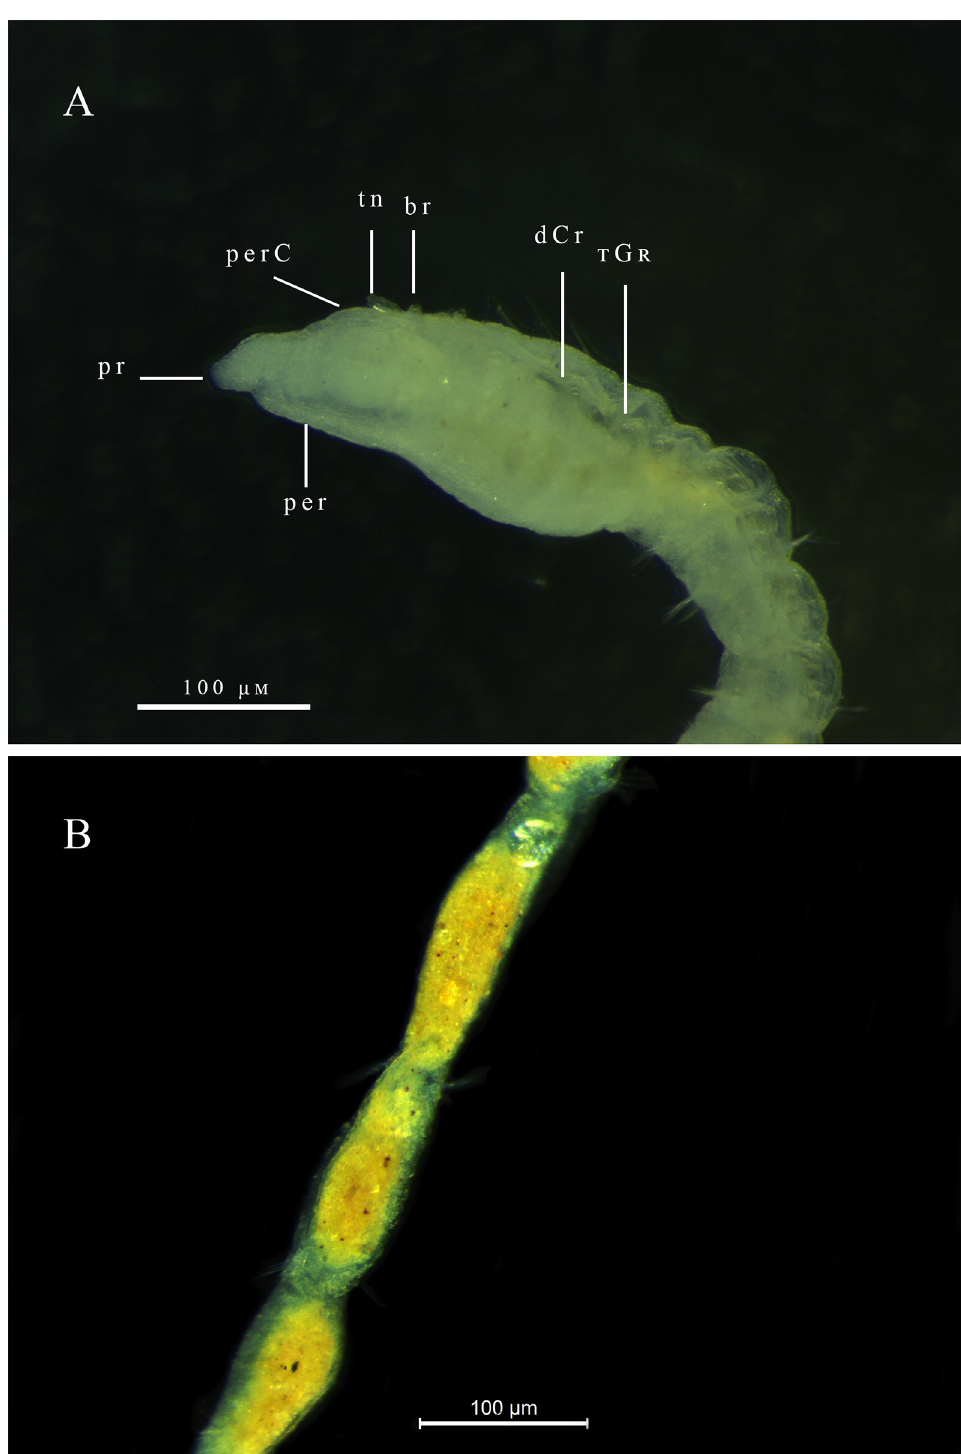
Fig 11. Kirkegaardia papaveroi sp. nov. (A) Anterior end, lateral view; (B) abdominal segments, dorsal view. A and B (MNRJP-003008). Type locality. Atlantic Ocean: Campos Basin (Brazil). Habitat. Sandy sediments, 14 and 145 m depth. Distribution. Presently known only from Atlantic Ocean: Campos Basin (Brazil). Methyl Green. No pattern, stain not retained.